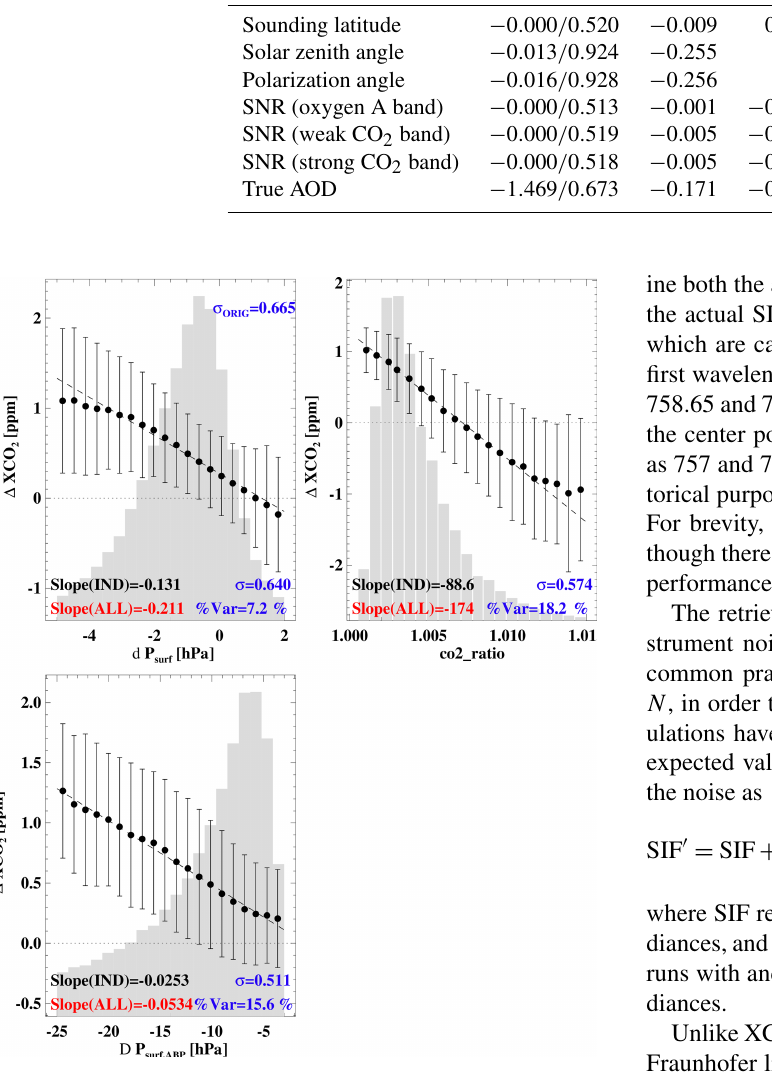
Figure 15. Same as in Fig. 14, but for glint–water scenes. Here the leading retrieval variables that explain the maximum variance are the L2FP dp, the IDP co2_ratio, and the ABP